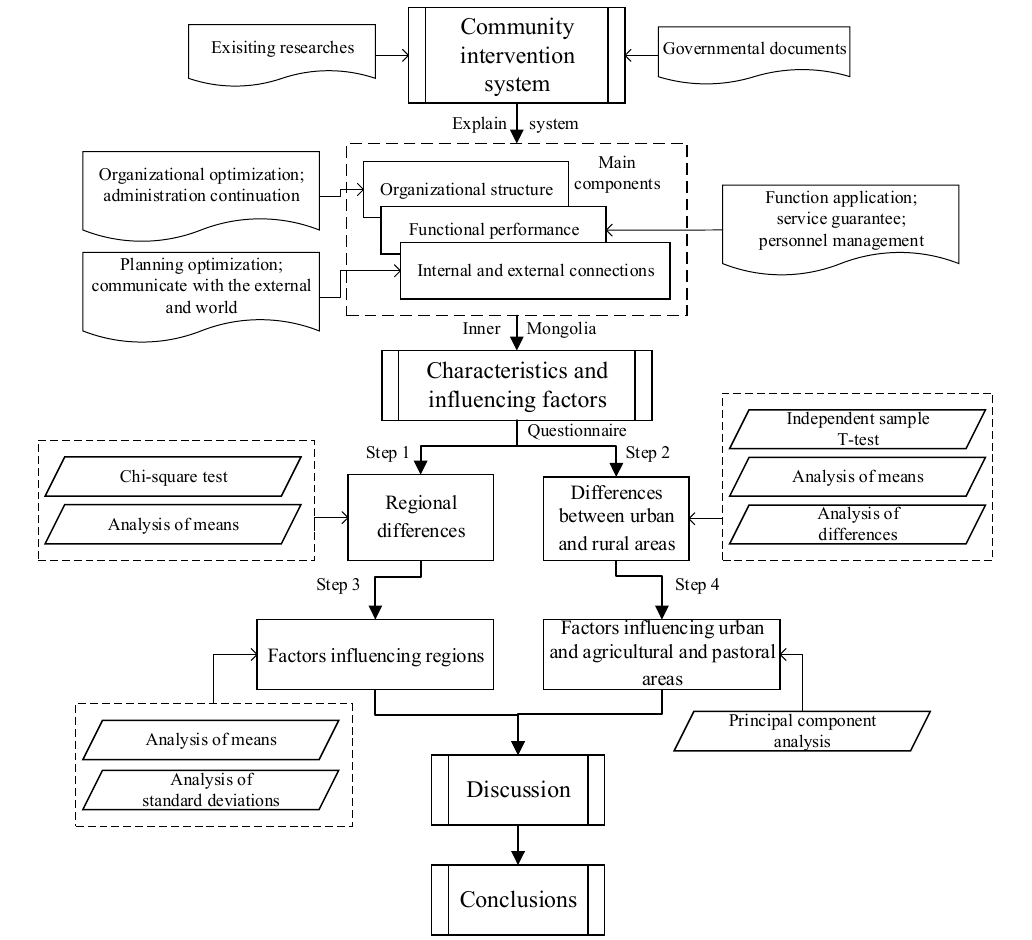
Figure 3. Flowchart of research.